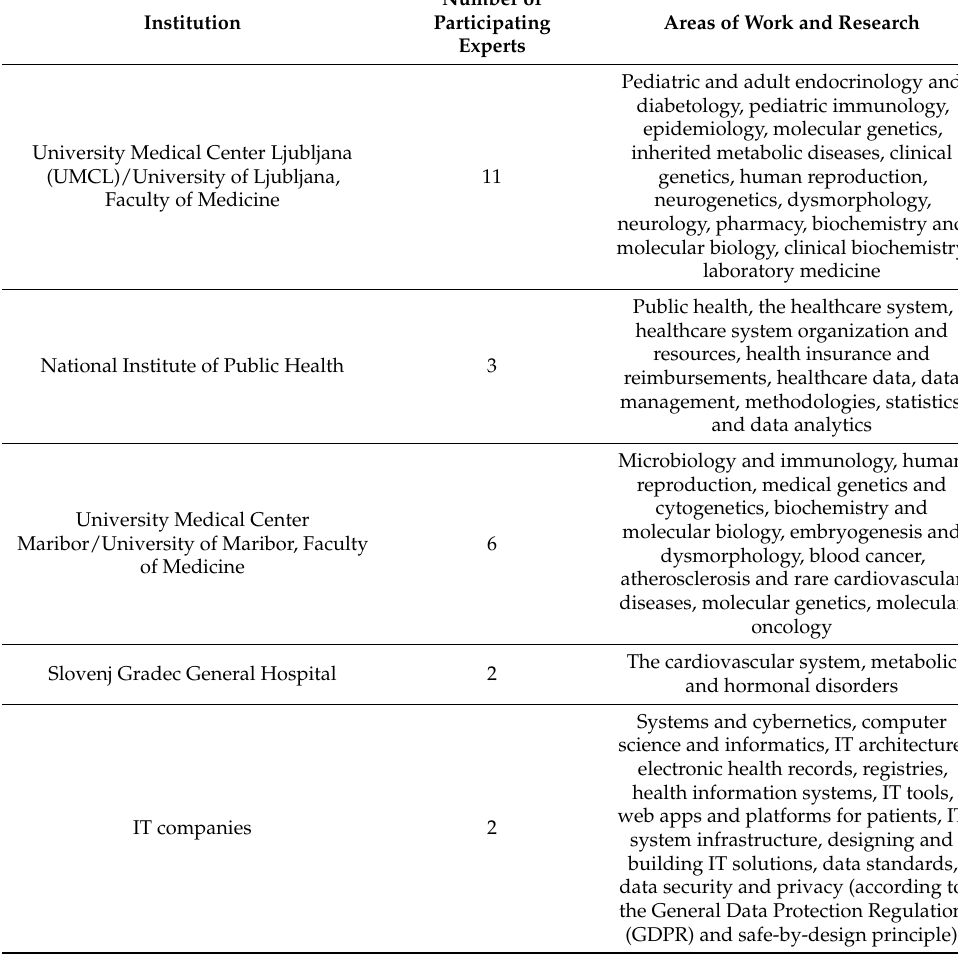
Table 1. Structure and characteristics of the